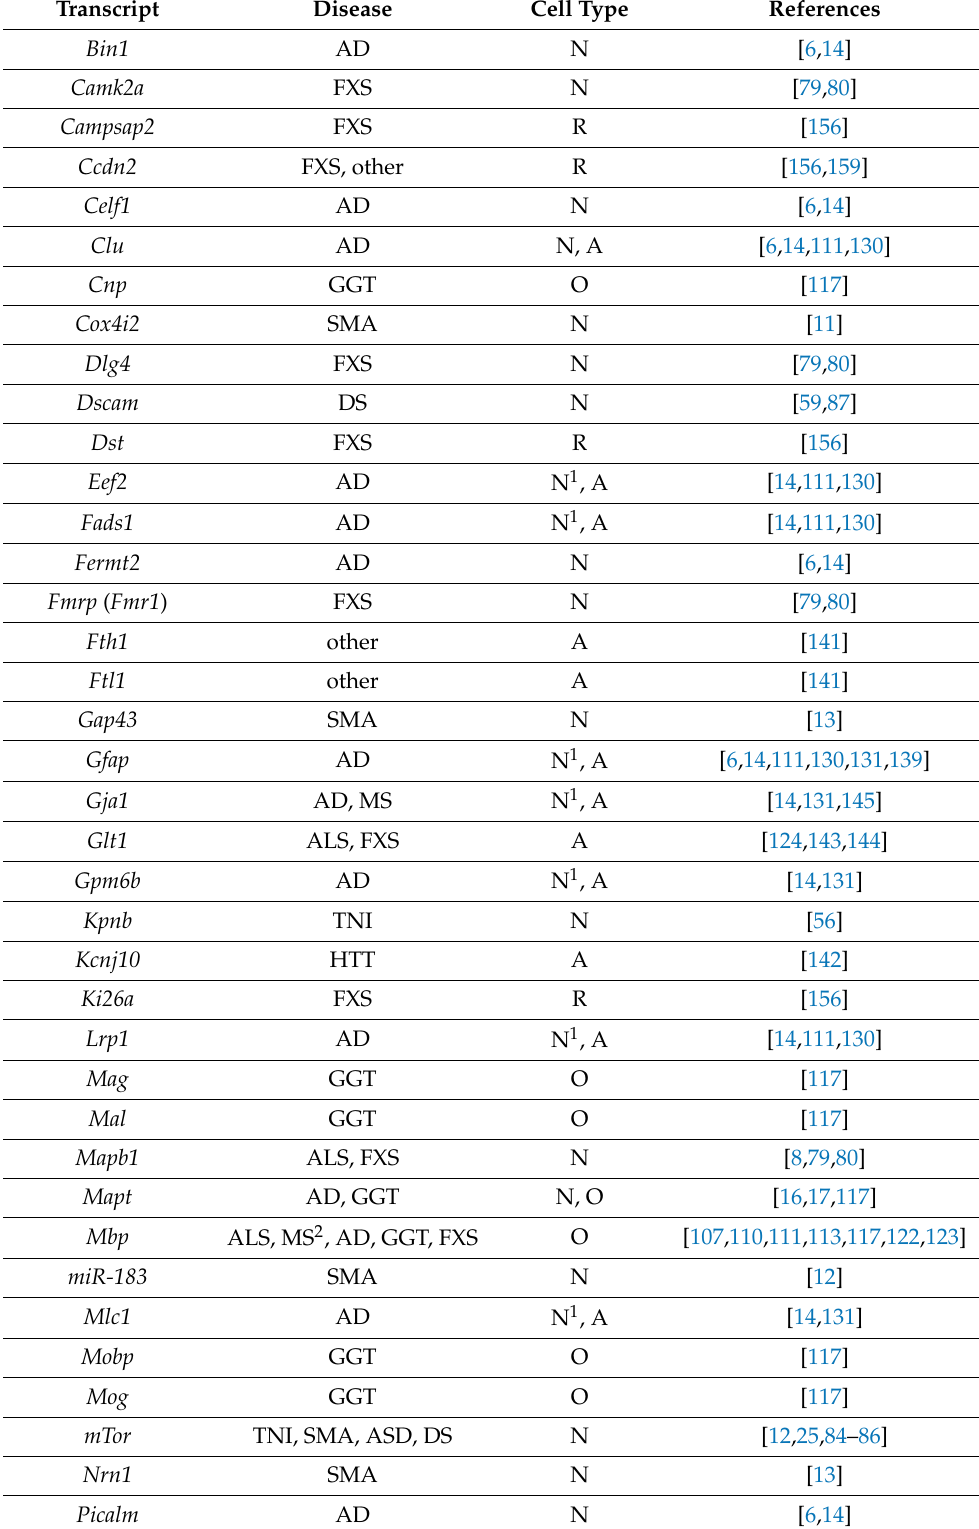
Table 2. Cont . List of mRNAs/microRNAs Localized to Subcellular Compartments in Neurons and Glia and Implicated in